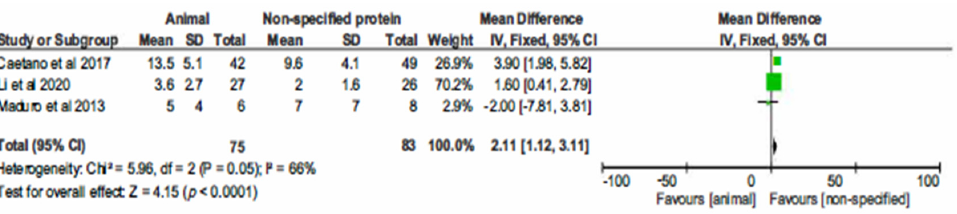
Figure 2. Forest plot of comparison: 1 Animal protein vs. unspecified protein, outcome: 1.1 CRP.